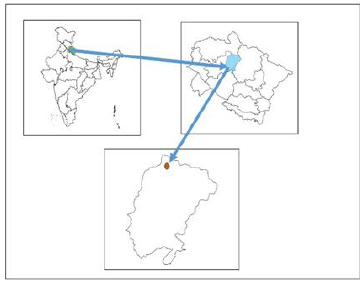
Figure 1. Study Area